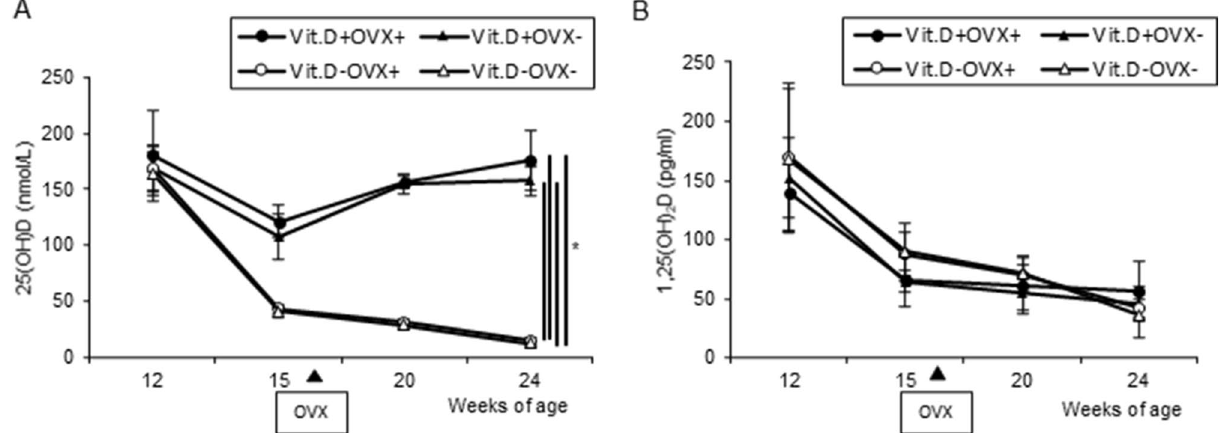
Figure 2. Serum levels of 25(OH)D and 1,25(OH)2D in preliminary study. Sera were collected at 12 weeks of age (initiation of diet with vitamin D–deficient or vitamin D–containing), 15 weeks, and 20, 24 weeks, and subjected to 25(OH)D and 1,25(OH)2D examination. ( A ) Serum levels of 25(OH)D of preliminary experiment. ( B ) Serum levels of 1,25(OH)2D of preliminary experiment. * p <